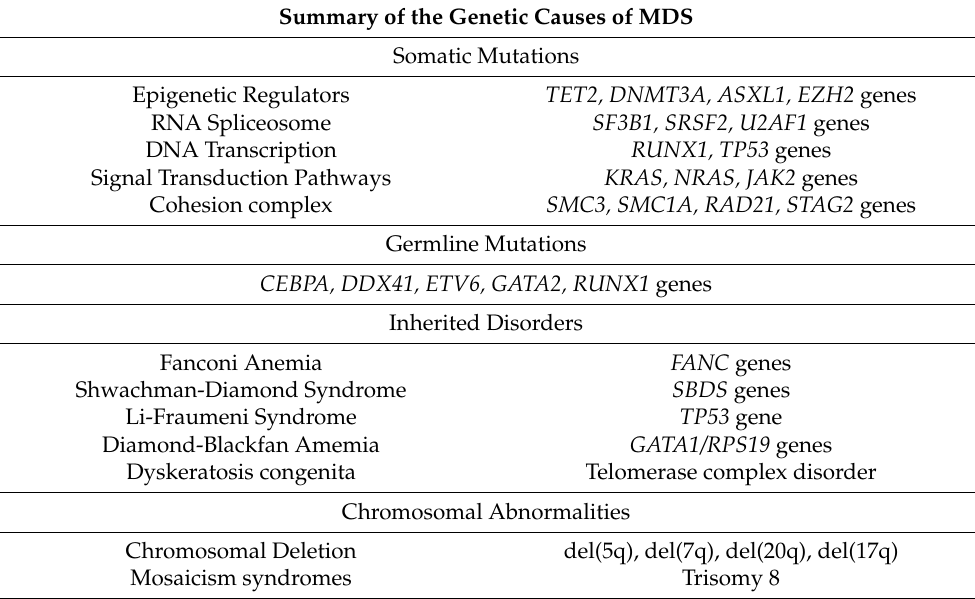
Table 2. Summary of the generic causes of MDS discussed in this